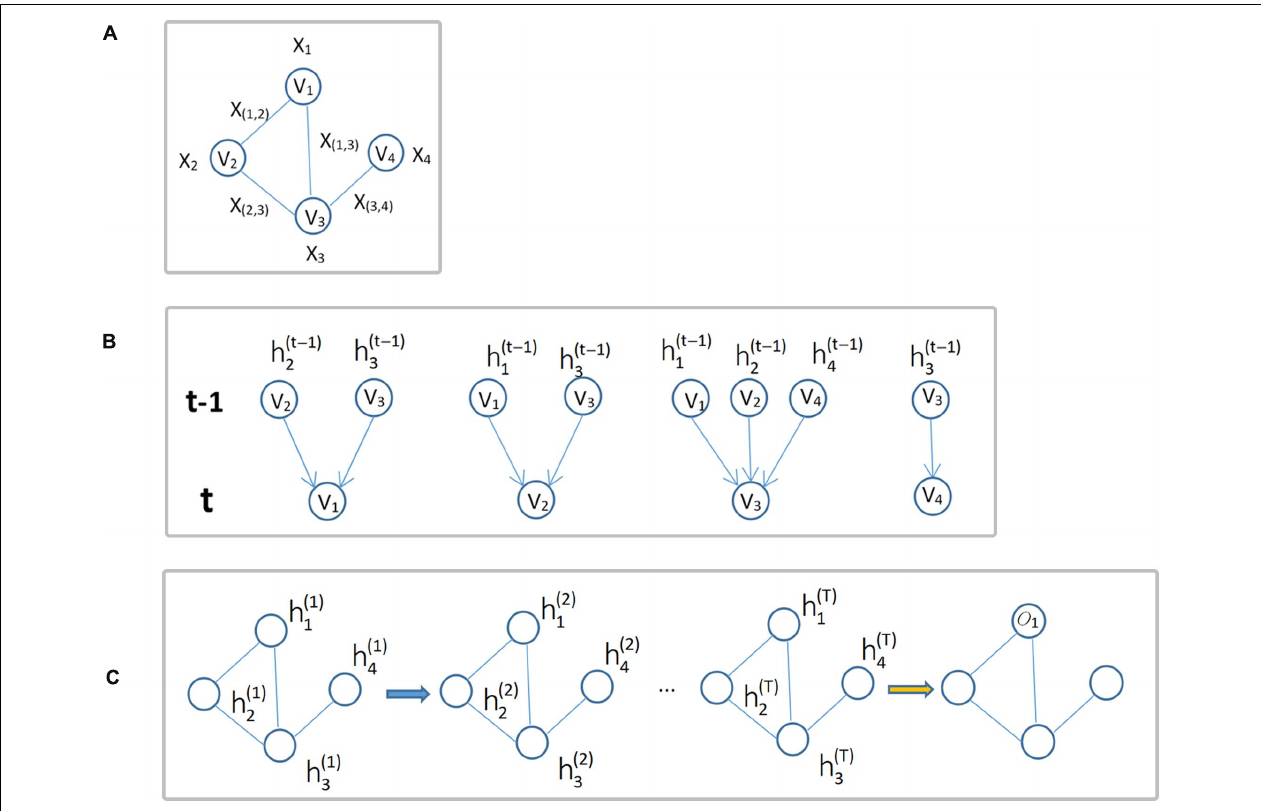
FIGURE 3 | Update of node status. (A) Input graph structure data G. (B) Diagram of each node iteration from time t -1 to time t . (C) The overall iteration process, where o i is the output of the i -th node